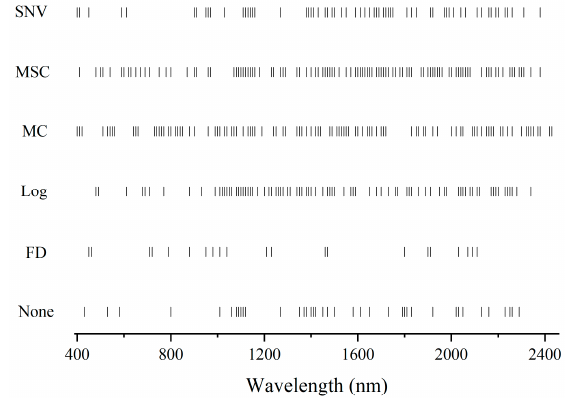
Figure 8. The distributions of spectral variables selected by Random Frog (RF) with different spectral pretreatments.